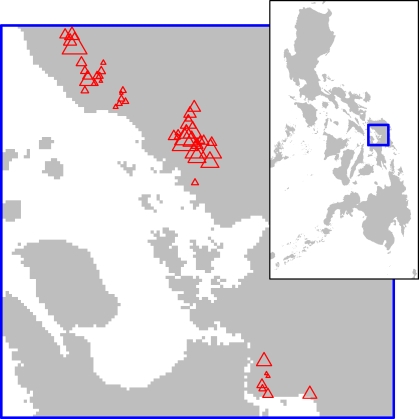
Spatial Distribution of the Underlying Rate of Transmission between Snails and Mammals βSM(j) under the Best Fit Hypothesis, H
2
The linear size of the red triangles is proportional to the value of βSM(j). The outset chart shows the location of the study region in the Philippines. North is towards the top of the page in both charts.